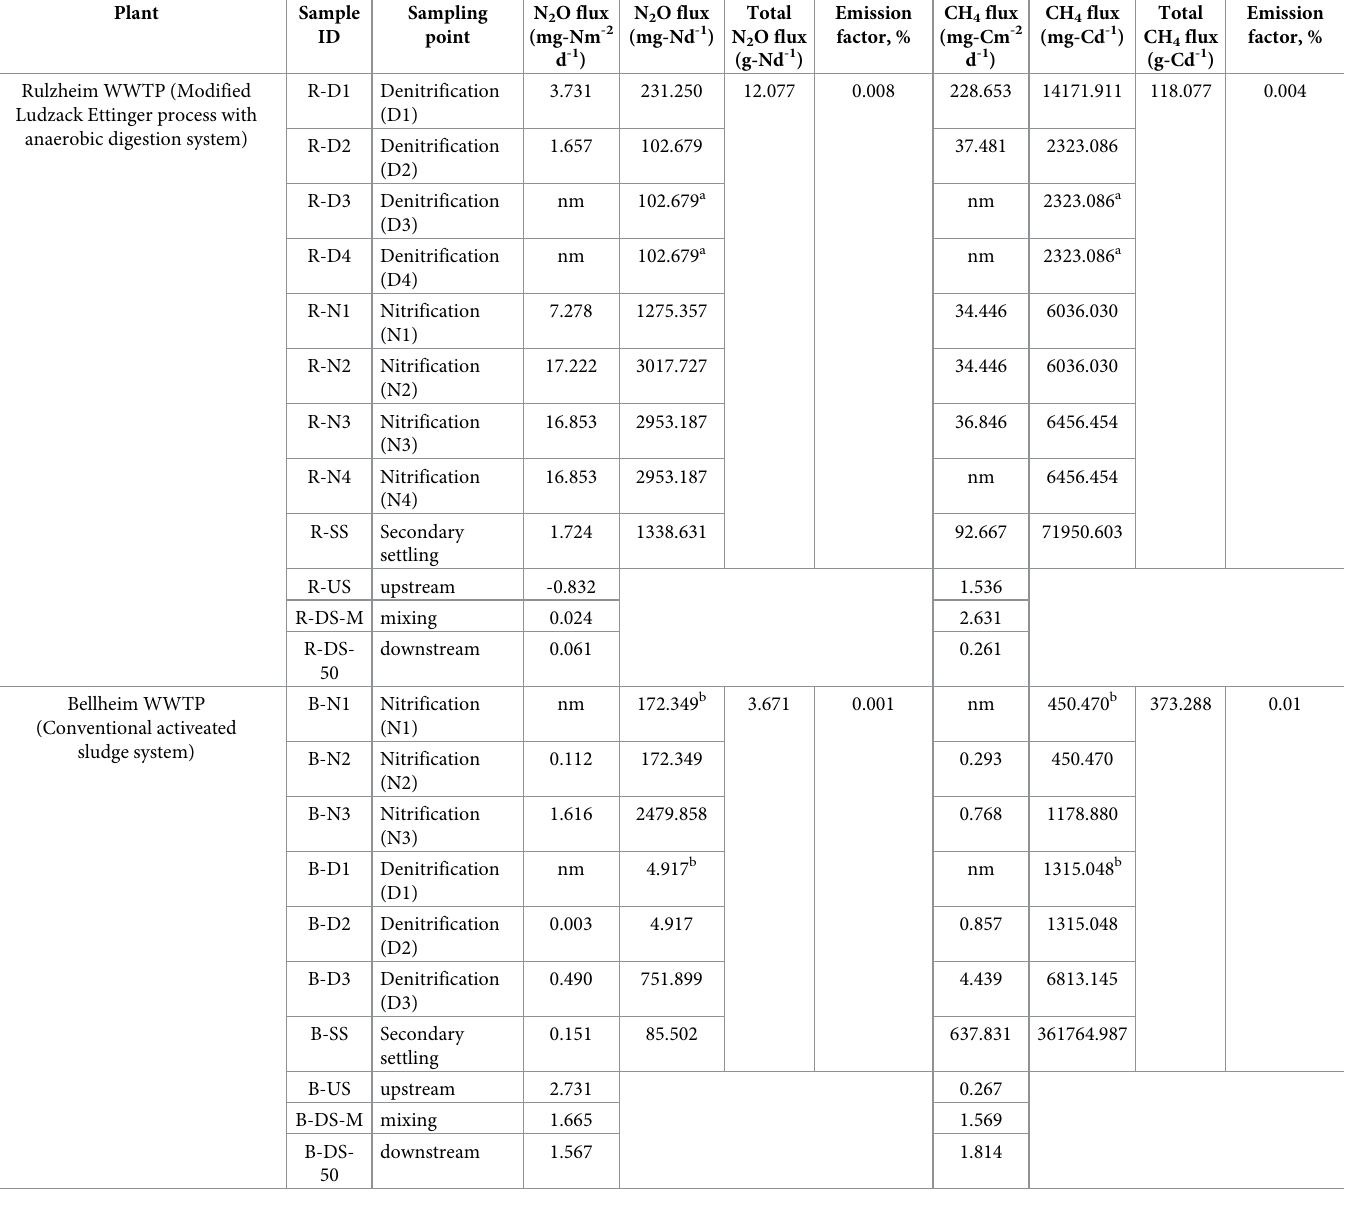
Table 2. Estimated fluxes emitted from WWTPs and nearby receiving streams and corresponding emission factors.